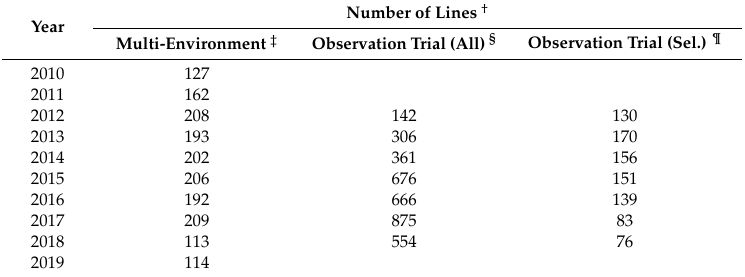
Table 1. Overview of the plant material tested between 2010 and